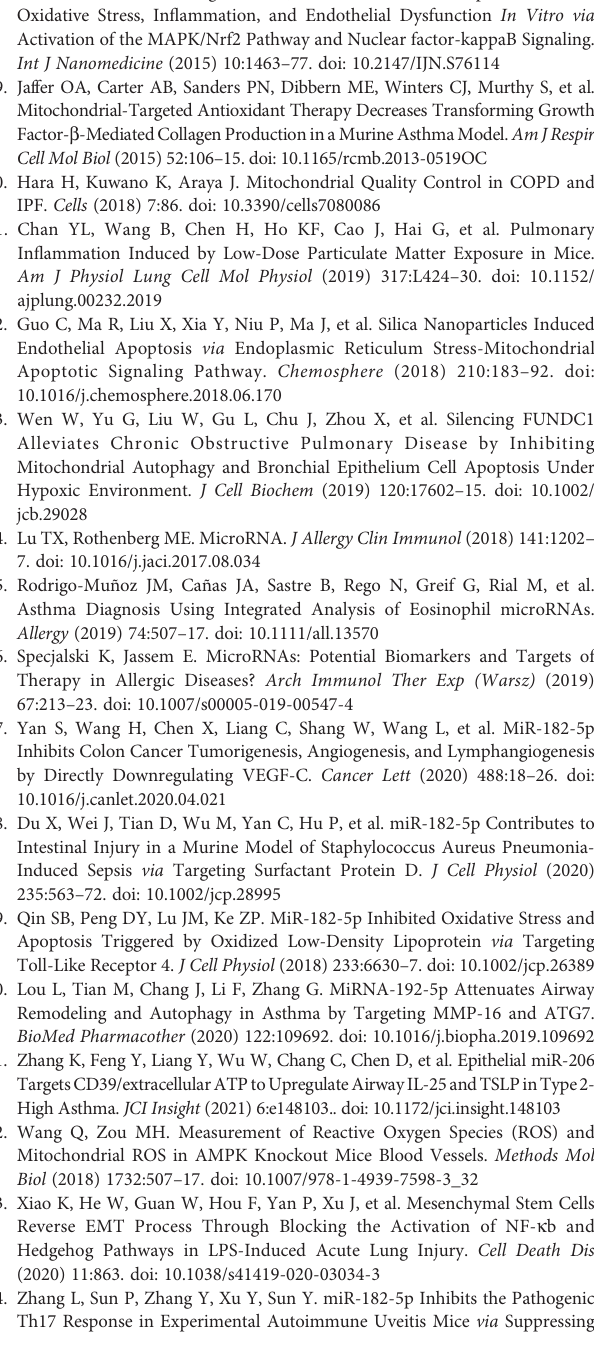
Supplementary Figure 1 | Schematic diagram of asthma model construction and miRNA-182-5p